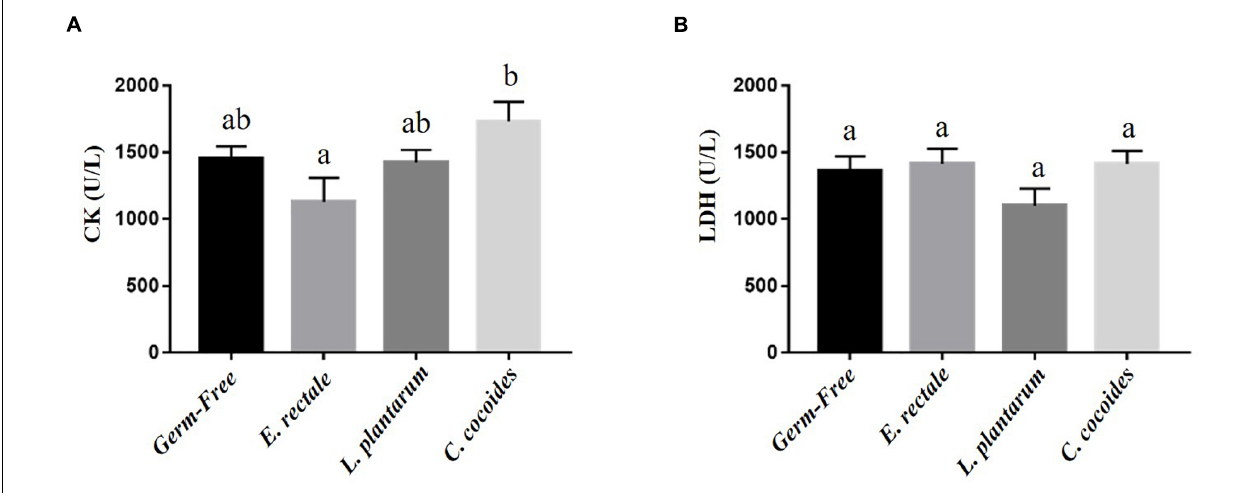
FIGURE 5 | Effect of indicated gnotobiotic groups on the serum CK (A) and LDH (B) levels after the exercise challenge. Data are mean ± SEM ( n = 6–8/group) and the columns with different superscript letters (a,b) are significantly different at P < 0.05.